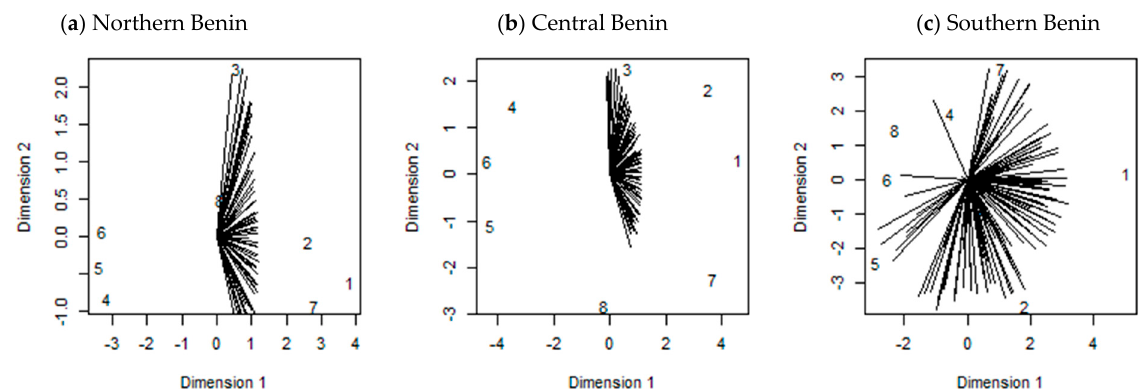
Figure 5. Most important items of cowpea cropping system and environment responsible for poor performance from northern to southern Benin: 1 = Insect pest and diseases; 2 = Soil Fertility decline; 3 = Unavailability of specific fertilizer; 4 = Unavailability of improved seed; 5 = Heavy rain; 6 = Late rain; 7 = Early drought; 8 = Weed proliferation. The constraints are labeled with consecutive numbers while the farmers are presented as vectors pointing from the origin to their most important constraint.